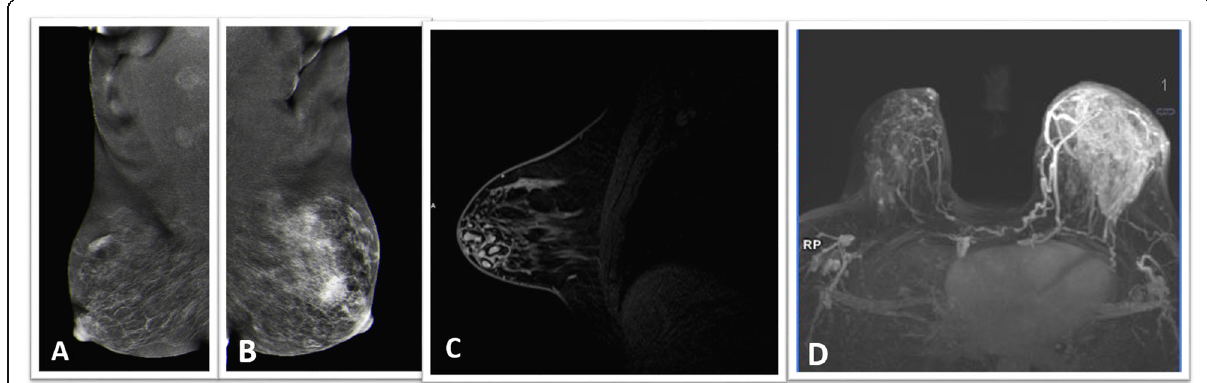
Fig. 5 A 54-year-old lady presenting with bilateral breast discharge. a , b Rt. and Lt. MLO recombined CESM; right breast shows an UOQ area of intense non-mass tubular enhancement with tubular distribution. Left shows an area of segmental enhancement. c Sagittal delayed DCE-MRI of the right breast shows multiple intraductal-enhancing retroareolar masses not seen on CESM. d CE-MRI-MIP image shows the area of segmental non-mass enhancement within the left breast. Histopathology revealed bilateral papillomatosis with granulomatous